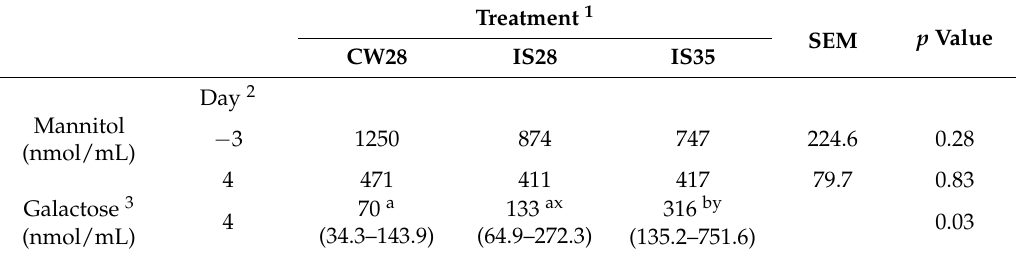
Table 3. Effect of intermittent suckling with and without an older weaning age on plasma mannitol and galactose concentrations (nmol/mL) of piglets before and after